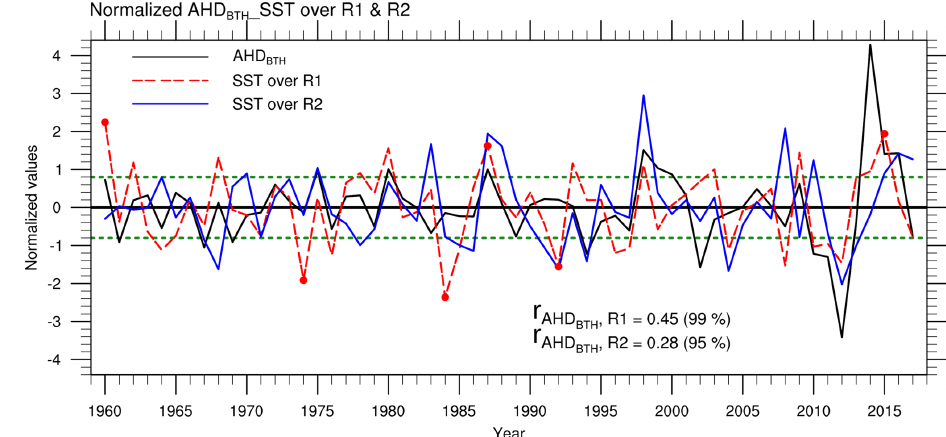
Figure 6. Time series of the normalized interannual component of the AHD BTH (black line), along with the simultaneous SST over R1 (red line) and R2 (blue line) for the period 1960–2017. The horizontal dashed lines denote 0.8 of the standard deviation. The numerals labeled at the bottom represent the correlation coefficients ( r ) between the AHD BTH and simultaneous SST over R1 and R2, respectively. The upper and lower dots on the red line indicate the three highest and lowest years of SST over R1, respectively.